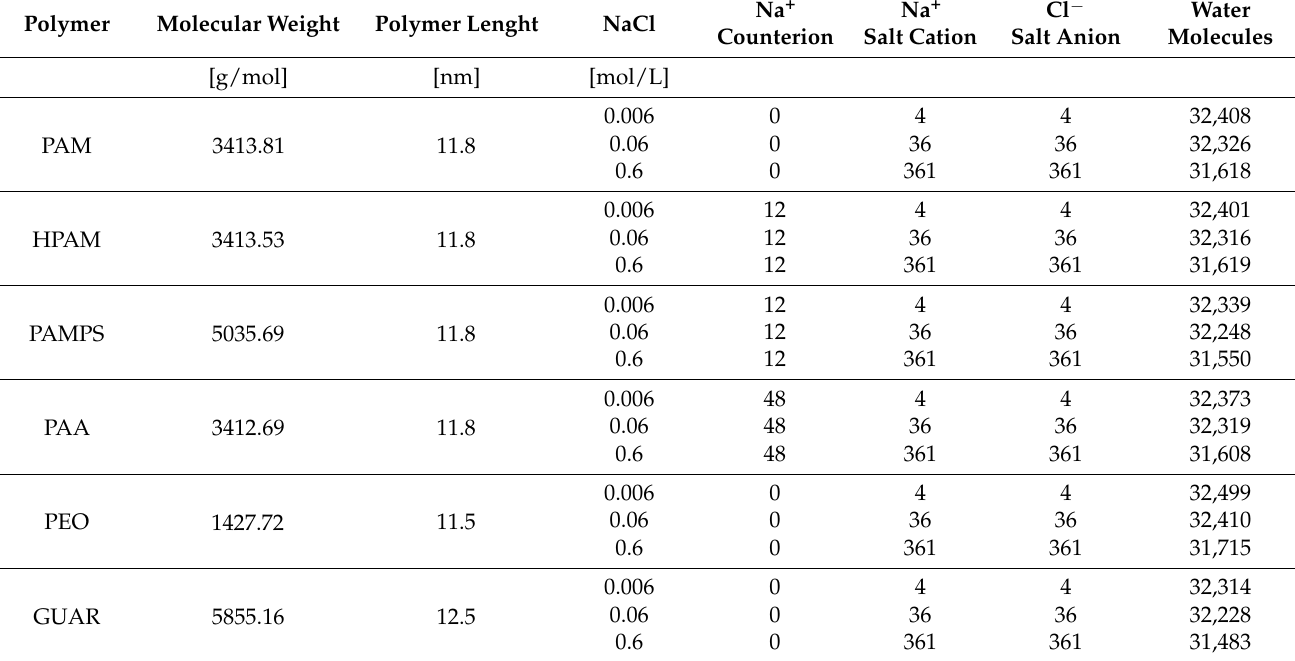
Table 1. Summary of the systems